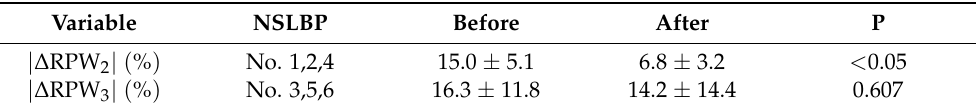
Table 5. Results of | ∆ RPW i | of patients with NSLBP before and after applying local vibratory stimulation to the poor